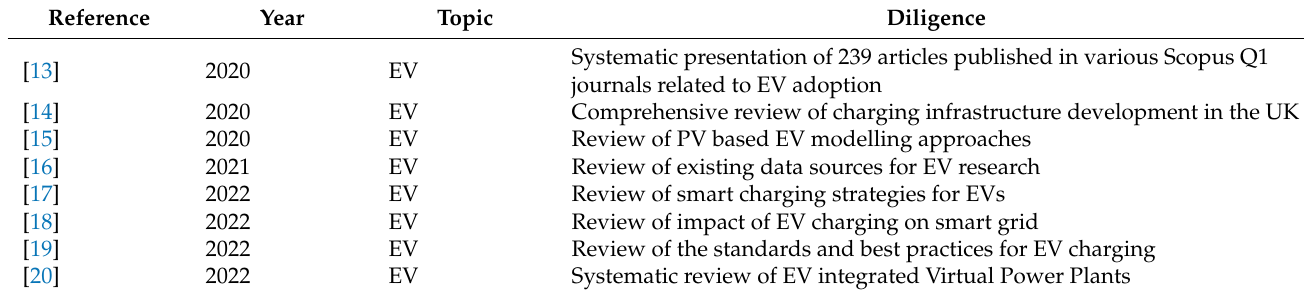
Table 1. Existing Reviews on EV and